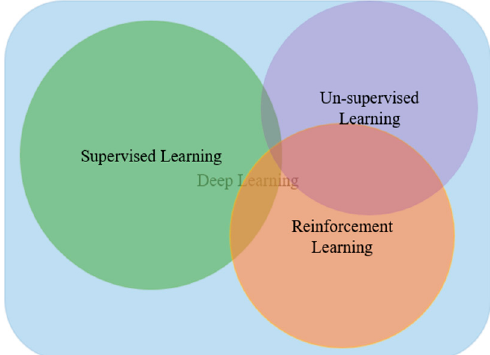
Figure 2. Category of Deep Leaning approaches.